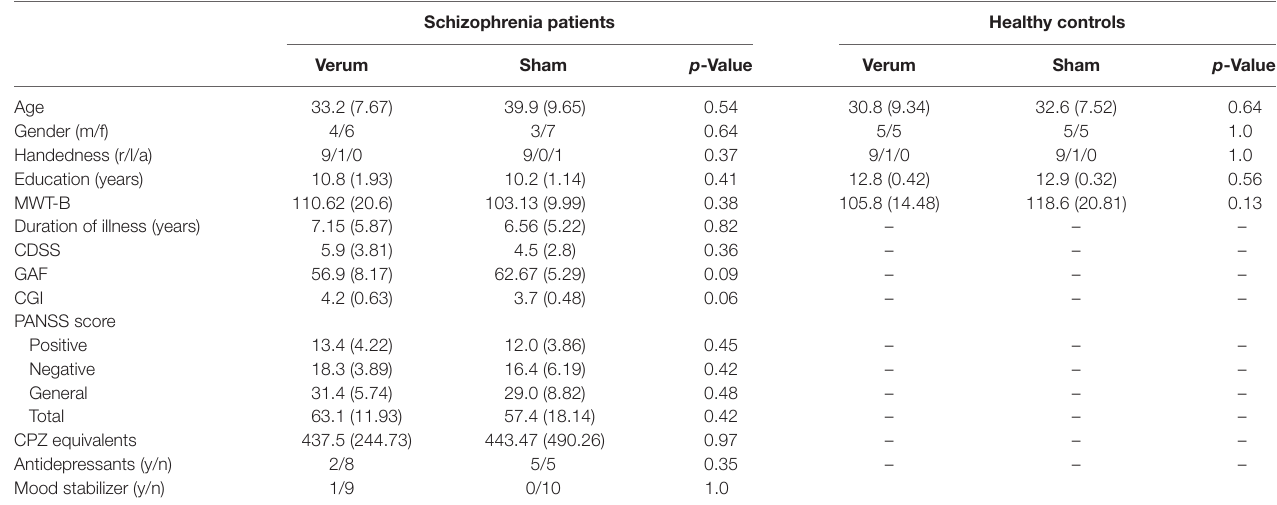
TaBlE 2 | Comparison of demographics and clinical ratings for verum and sham groups.